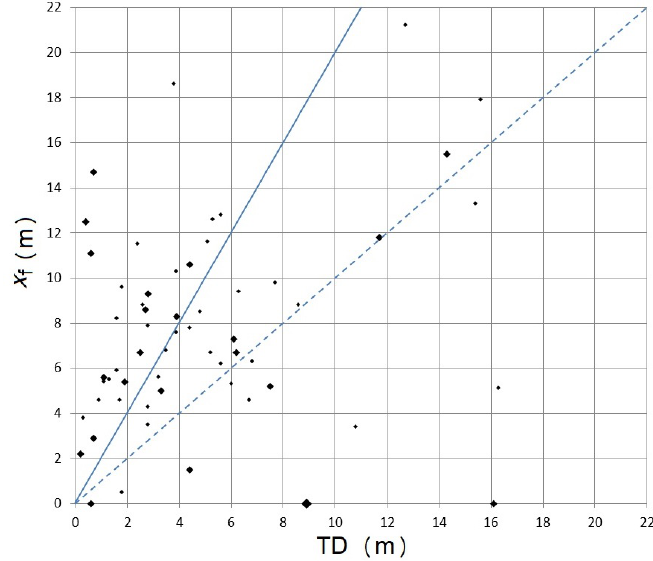
Figure 11. Final distance ( x f ) vs. Transport Distance (TD) diagram. Symbol size is related to the clast size (small = coarse boulder, medium = very coarse boulder, and large = fine